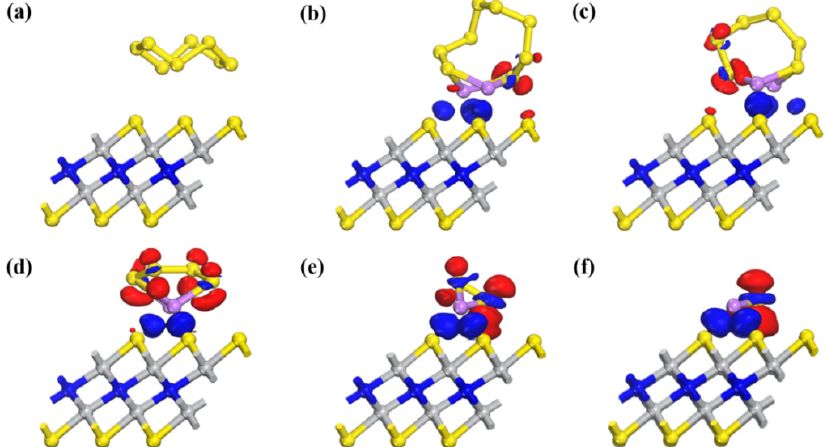
Figure 7. Charge density difference between ( a ) S 8 , ( b ) Li 2 S 8 , ( c ) Li 2 S 6 , ( d ) Li 2 S 4 , ( e ) Li 2 S 2 , ( f ) Li 2 S and Ti 2 NS 2 . The isosurface level is set to 0.025 e/Å 3 . The blue regions indicate charge accumulation, and the red regions indicate charge depletion.